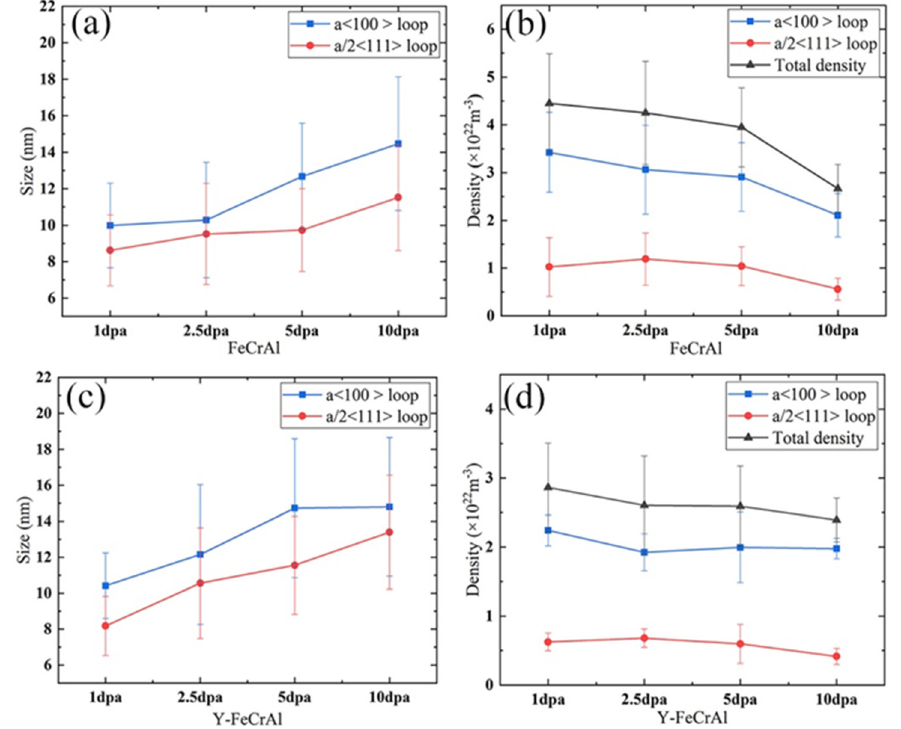
Figure 7. ( a ) average size and ( b ) density of dislocation loop in FeCrAl alloys, ( c ) average size and ( d ) density of dislocation loop in Y − FeCrAl alloys.